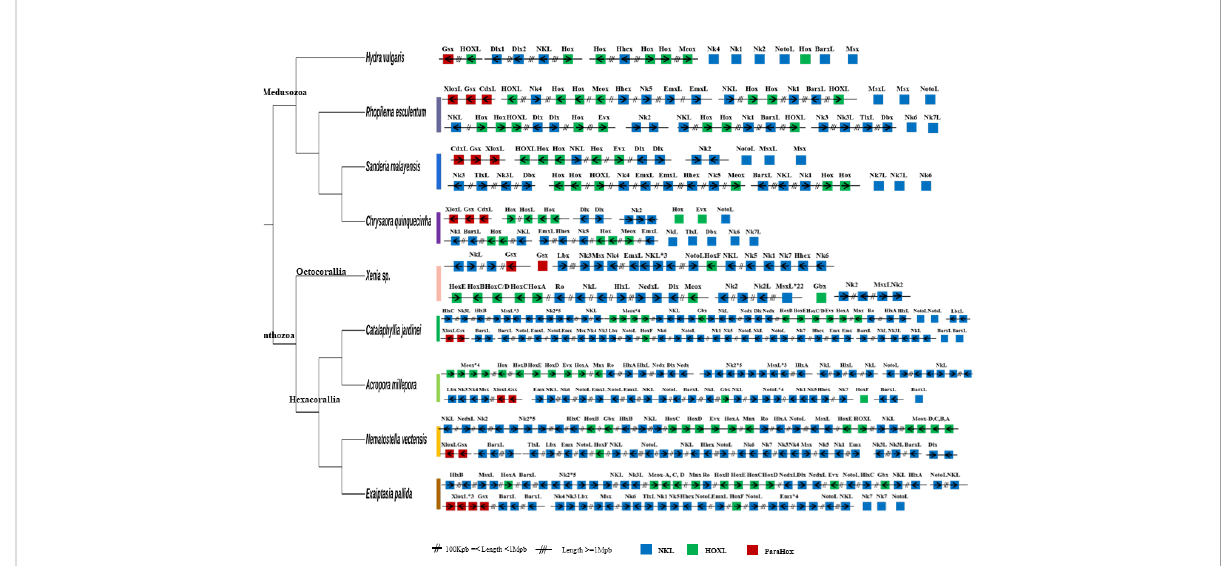
FIGURE 3 ANTP-class homeobox genes arrangement in high-quality cnidarian genomes. Double slash denotes genomic distance >100kb and <1Mb; triple slash denotes genomic distance over 1Mb.